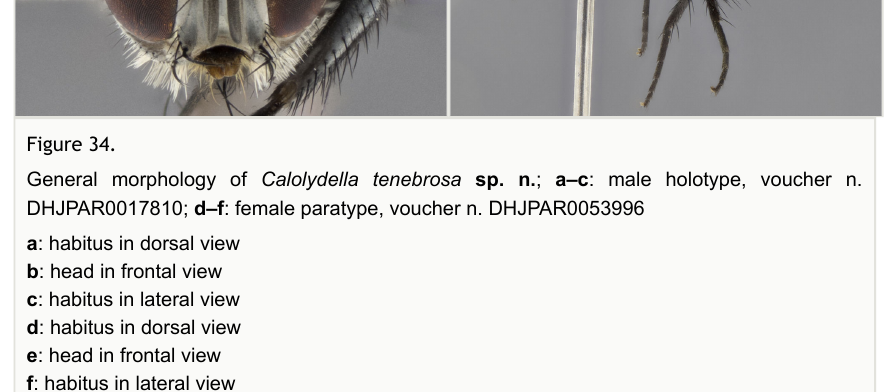
Female (Fig. 34d, e, f). Length: 6mm. As male, except for the following characters: fronto-orbital plate 1.41X as wide as in male; palps dark grayish-orange.